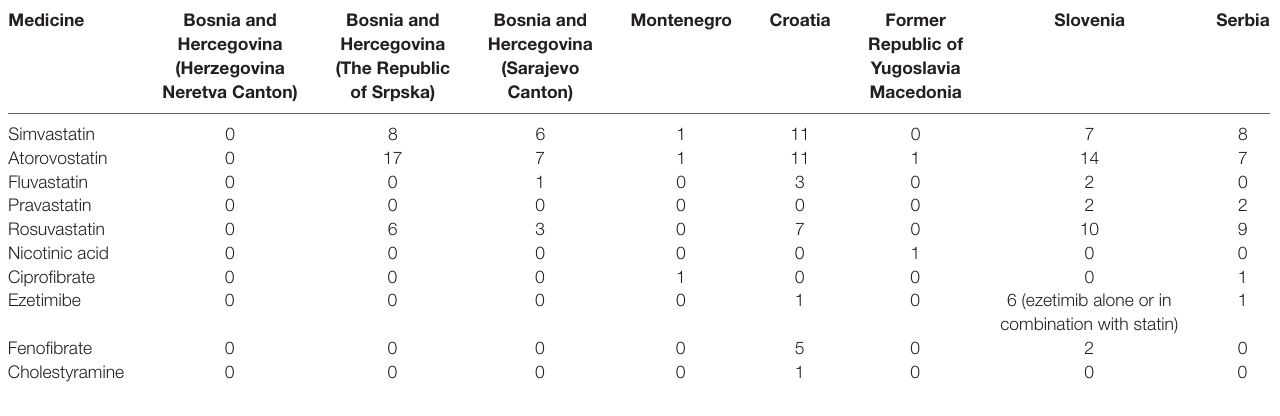
TaBle 5 | Number of parallels of oral hypolipidemic agents per country.